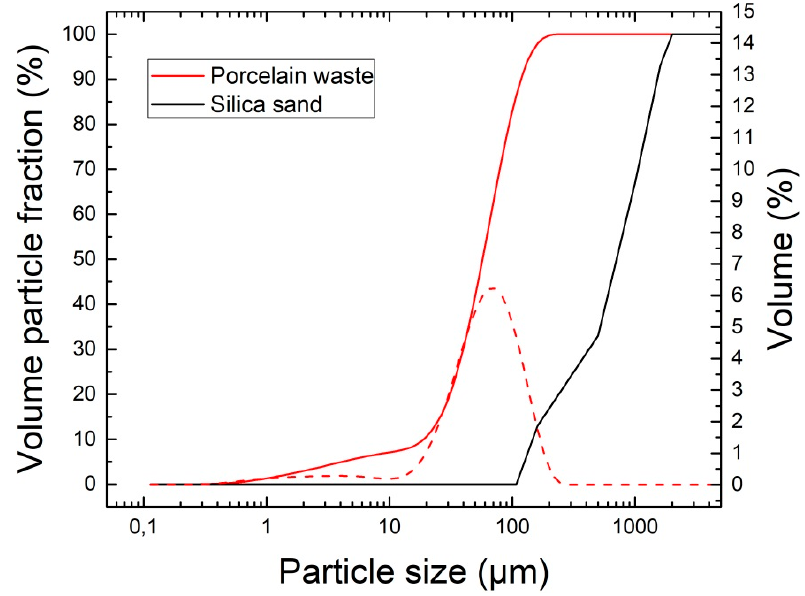
Figure 1. Particle size distribution of PW and silica sand.